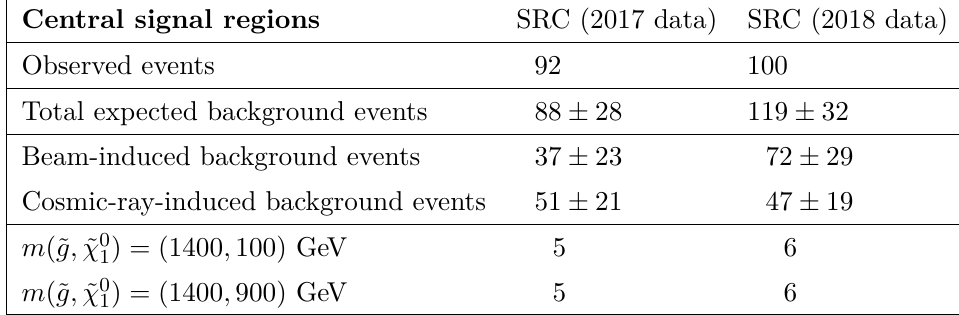
Table 5 . Breakdown of the expected and observed data yields in SRC in 2017 and 2018, integrated over the jet p spectrum. The quoted uncertainties include statistical and systematic contributions. T The expected event yields from two example signal models with a gluino mass of 1 . 4 TeV and neut- ralino masses of 100 GeV and 900 GeV are also included, where the yields are calculated assuming a gluino lifetime between about 10 − 5 and 10 3 s (within the range of the live-fraction plateau in